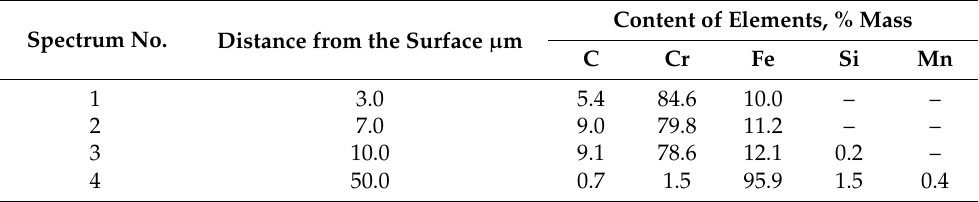
Table 3. Distribution of chemical elements in the coating for steel DIN C80W1 after